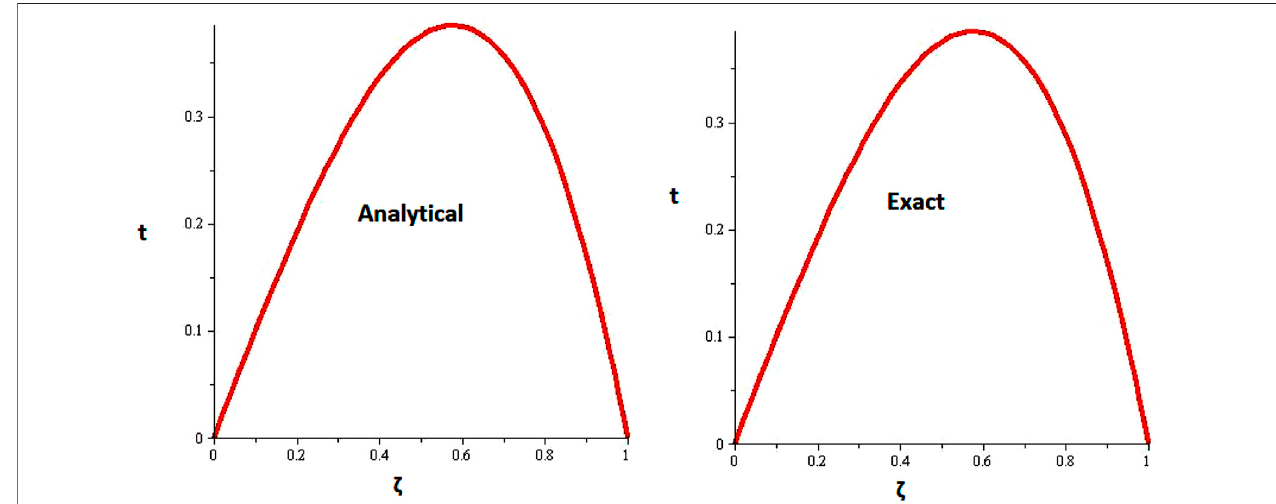
FIGURE 6 | 2D plots for the exact and analytical solution at γ =1 for Example 2.